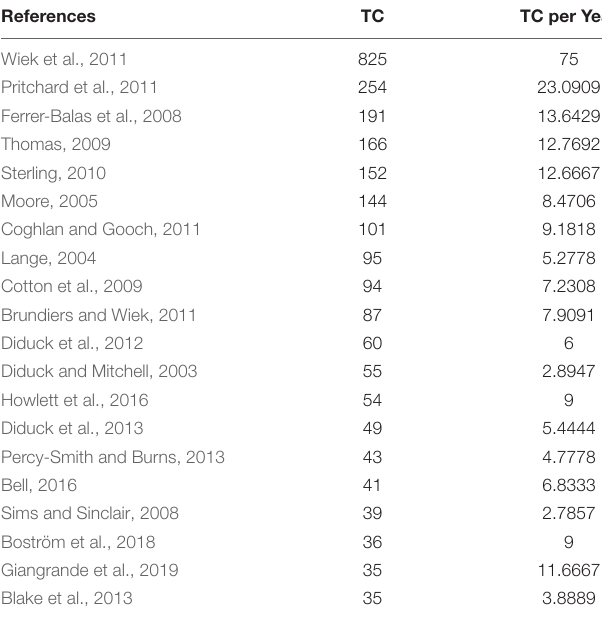
TABLE 4 | Most-cited documents related to transformative learning for sustainability